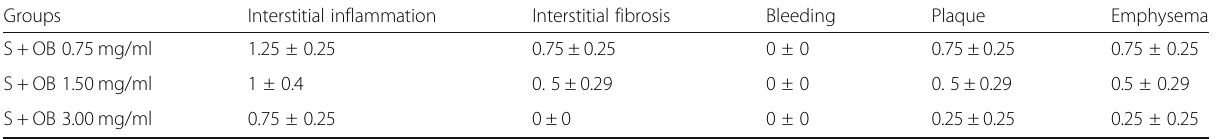
Table 4 Pathological changes in sensitized group treated with three different concentrations of O. basilicum (S + OB)